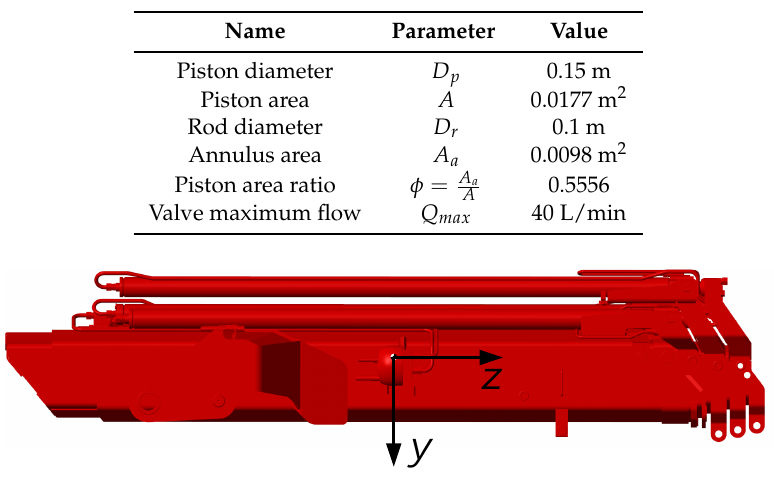
Figure 6. Illustration of the HMF 2020K4 loader crane. Table 1. Knuckle cylinder data.